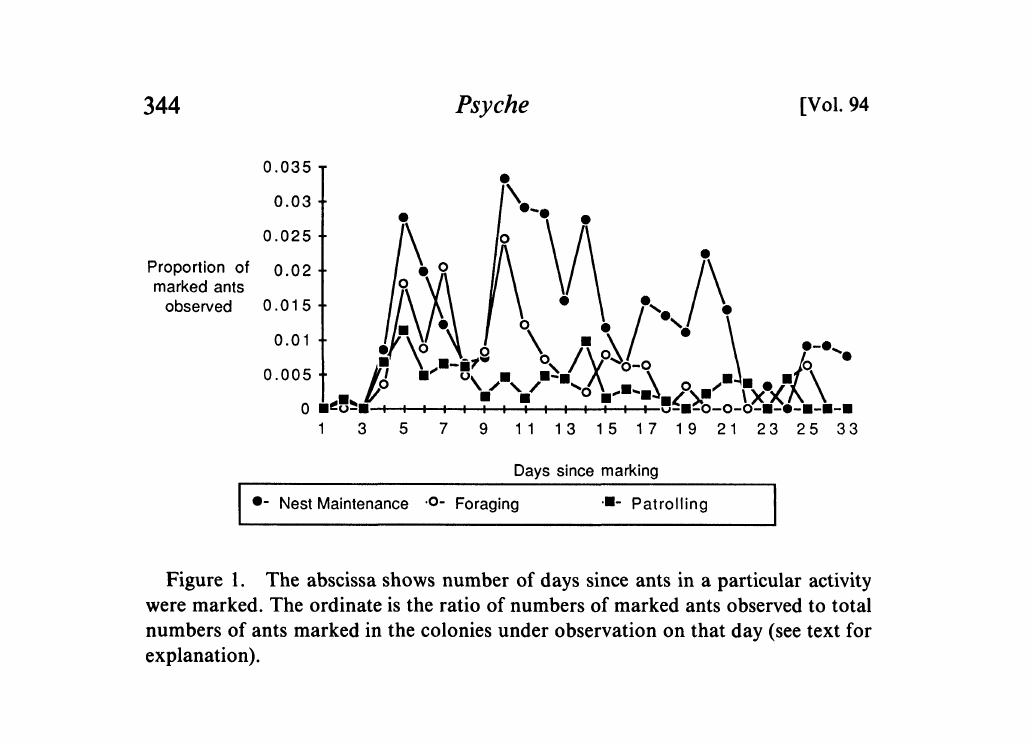
Figure 1. The abscissa shows number of days since ants in a particular activity were marked. The ordinate is the ratio of numbers of marked ants observed to total numbers of ants marked in the colonies under observation on that day (see text for